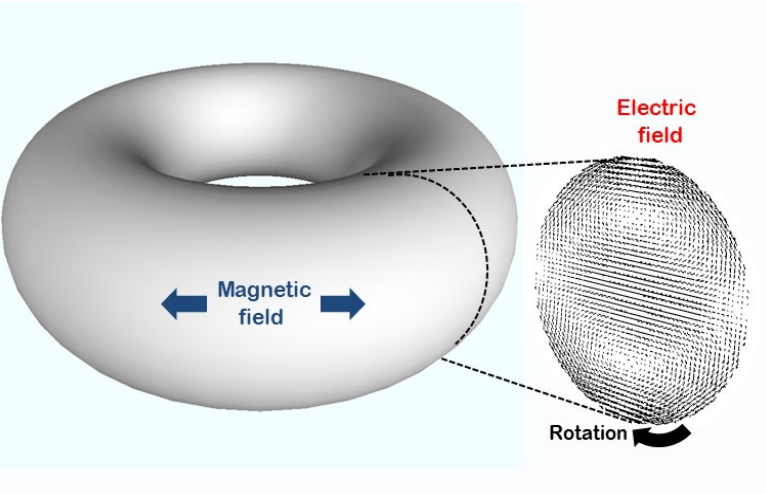
Figure 3. Electromagnetic fields circulating in a toroid cavity Σ . The electric field lies on each vertical section, whereas the magnetic one is distributed parallel to the large circumference. The time evolution recalls that of a fluid dynamics vortex